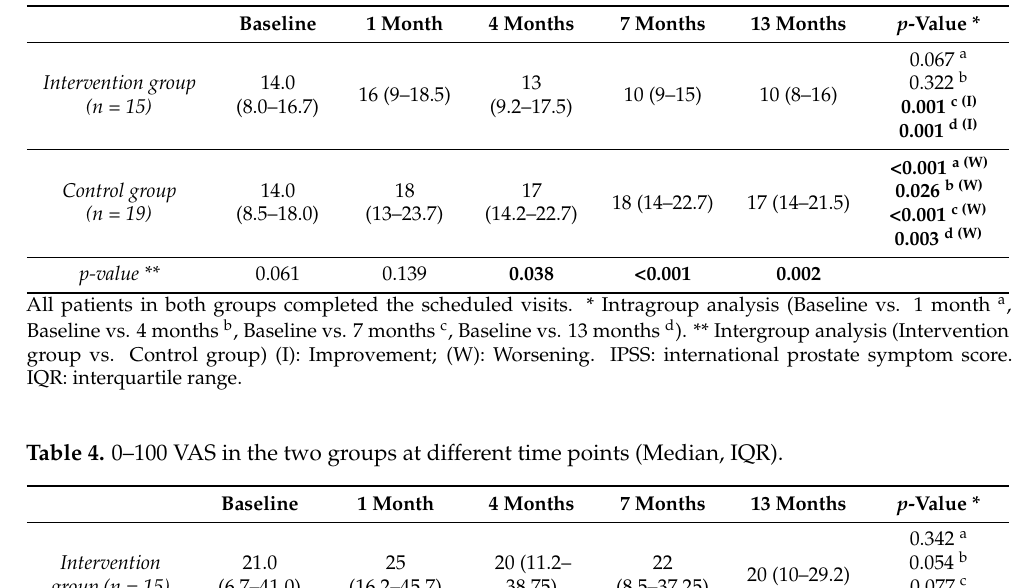
Table 3. IPSS in the two groups at different time points (median, IQR).